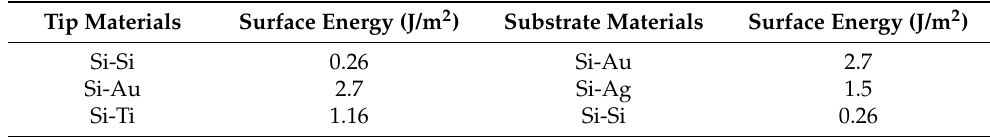
Table 3. The tip and substrates’ values of surface energy